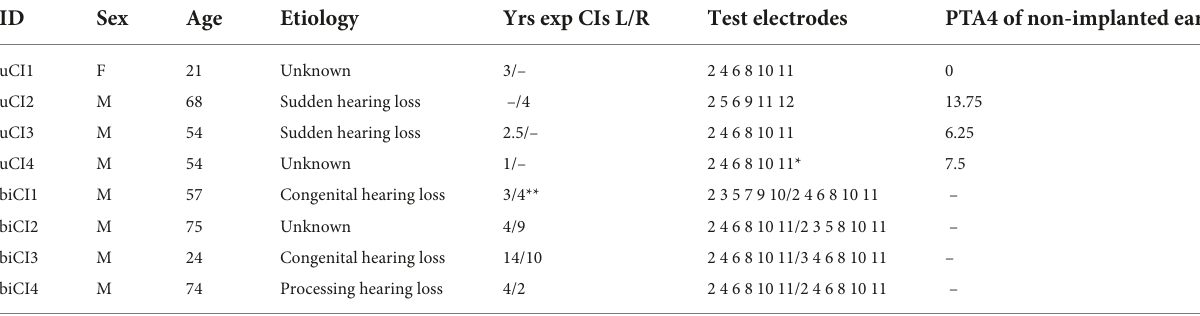
TABLE 1 Demographic information of the CI participants including gender, age at testing, etiology, years of electric experience for the left and right implant (yrs exp CIs), the test electrodes, and PTA4 of non-implanted ear.